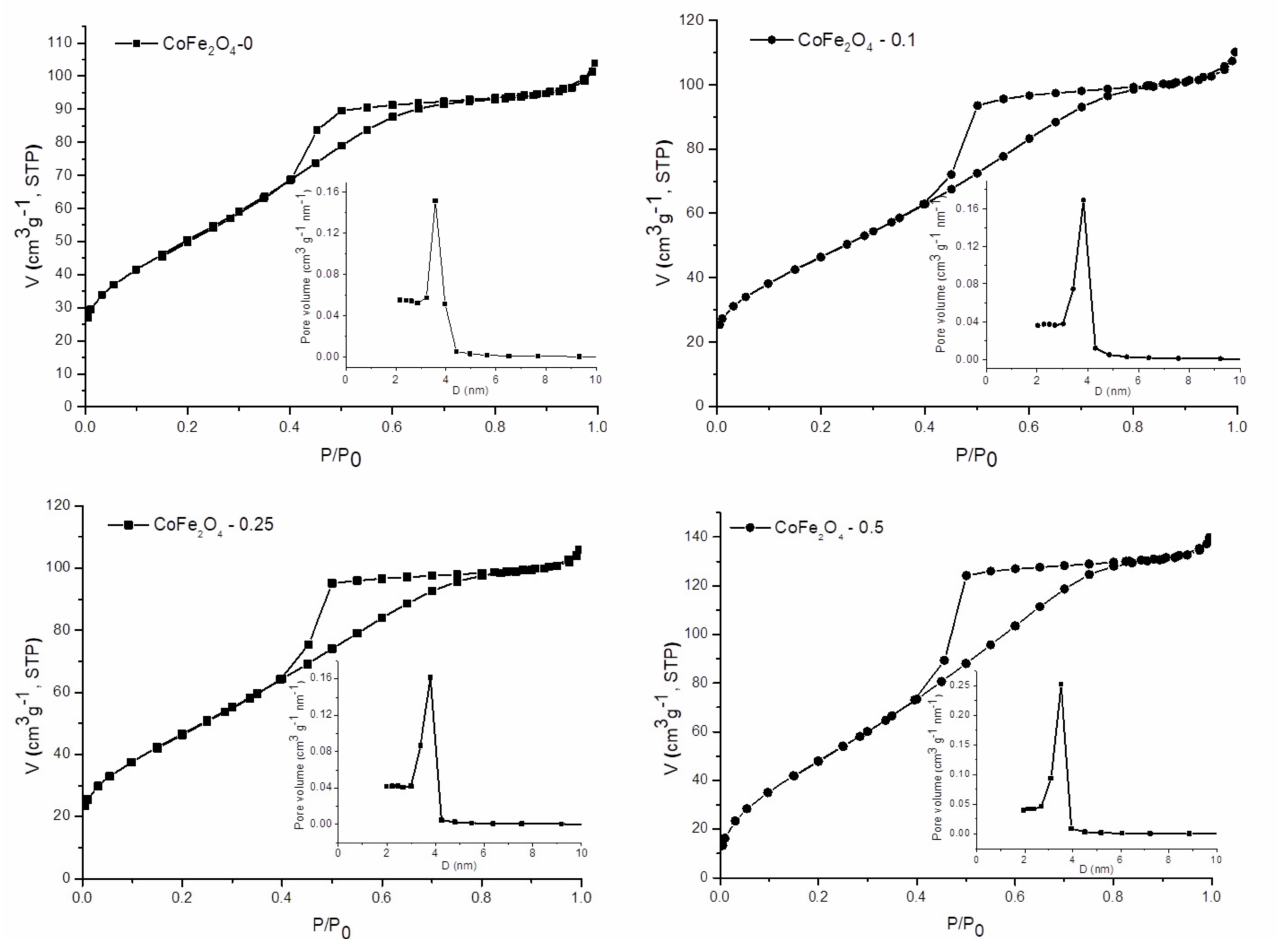
Figure 10. N 2 adsorption − desorption isotherms and pore size distribution (inset) of the